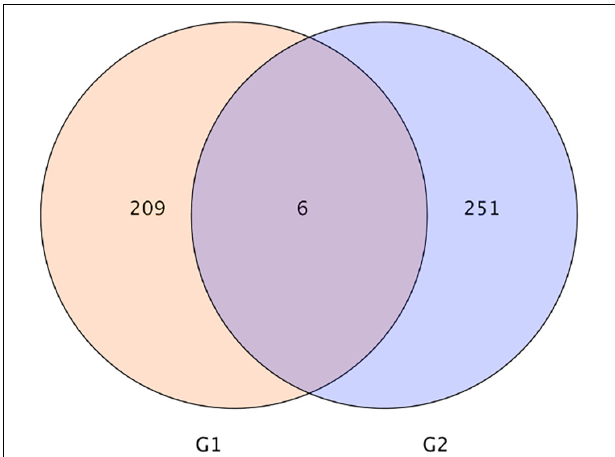
FIGURE 3 | |Venn diagram of DEGs of control condition combined with B. cereus (CK + B) vs control (CK) and salt stress combined with B. cereus (S + B) vs salt stress (S) comparison in G. uralensis . G1, DEGs of CK + B vs CK; G2, DEGs of S+B vs S.